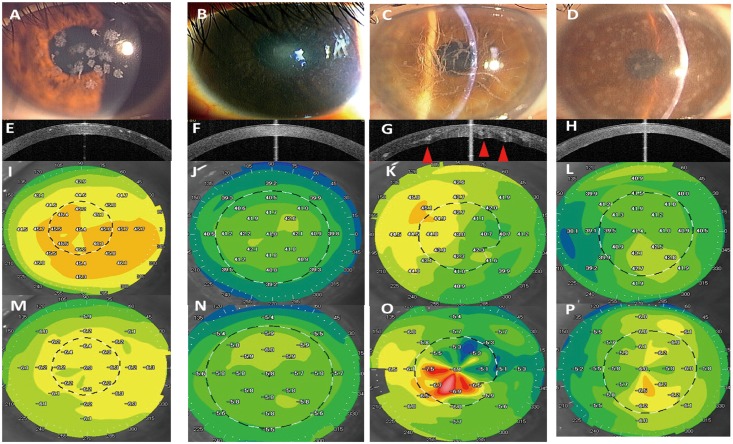
Representative cases of granular corneal dystrophy type2 (GCD2), lattice corneal dystrophy type 1 (LCDI), lattice corneal dystrophy type 3A (LCDIIIA) and macular corneal dystrophy (MCD) and the anterior segment optical coherence tomography (AS-OCT) images and topography maps of anterior and posterior corneal surfaces.The representative slit-lamp photographs (A-D), AS-OCT images (E-H), topography maps of anterior (I-L) and posterior (M-P) surfaces of GCD2 (A, E, I and M), LCDI (B, F, J and N), LCDIIIA (C, G, K and O), and MCD (D, H, L and P). In the slit-lamp photographs, the corneal opacities were scored as grade1 in GCD2 (A), grade 1 in LCDI (B), grade 2 in LCDIIIA (C) and grade 3 in MCD (D). In AS-OCT images and topography maps of GCD2, highly-reflective stromal opacities with clear boundary were embedded in the subepithelial and anterior stroma with minimal effects on anterior surface irregularities and no effects on posterior surface irregularities. AS-OCT images and topography maps in LCDI and MCD show diffuse clouding of full-thickness depth, with minimal irregularities in LCDI and moderate irregularities in MCD. In LCDIIIA, the irregularities of the posterior surface co-localize with lattice opacities in the deep stroma (red arrow heads).